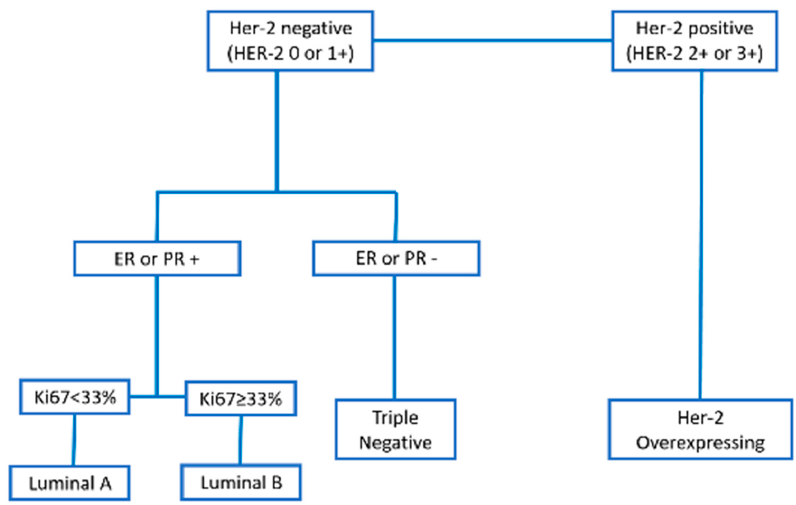
Figure 1. Classification of the molecular phenotypes of canine mammary carcinomas according to each immunohistochemical marker.